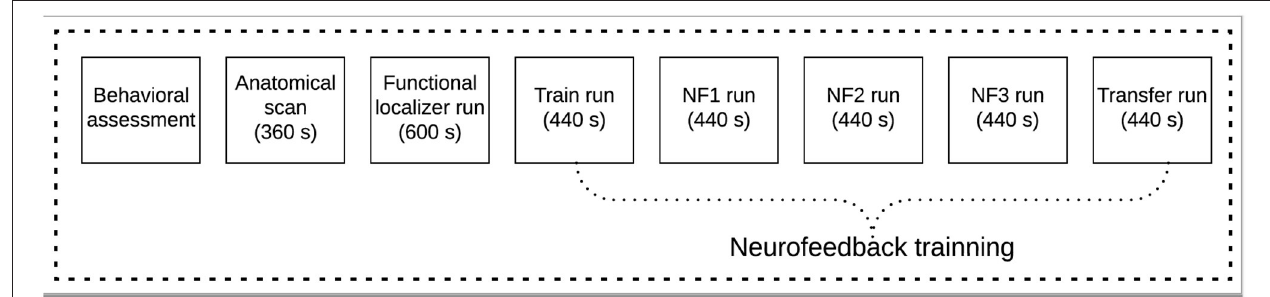
FIGURE 1 | Experimental protocol scheme for the neurofeedback based on real-time functional magnetic resonance imaging (rt-fMRI-NF) pain empathy